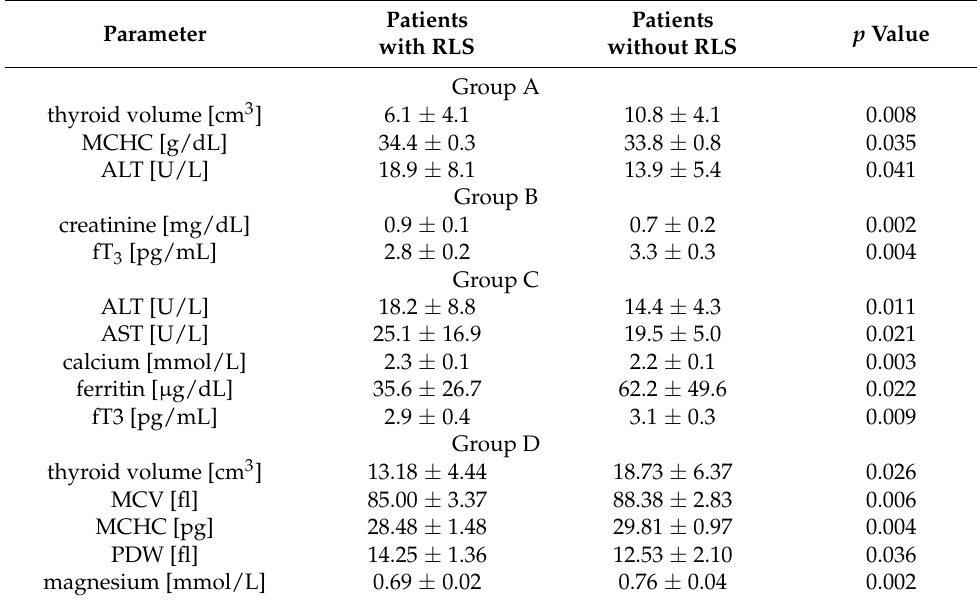
Table 4. Statistically significant differences between patients with and without RLS, distinguished into groups A, B and C.